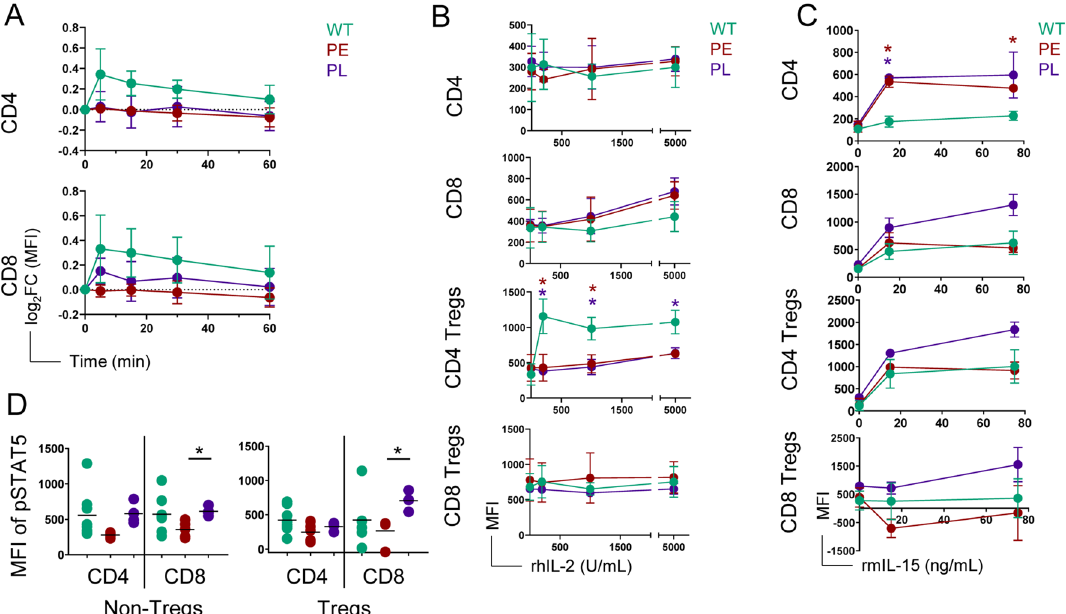
Figure 6. IL-2Rα-KO T cells respond differentially to cytokine stimulation. ( A ) Log 2 fold change of S6 phosphorylation by mean fluorescent intensity (MFI) from unstimulated over time following TCR stimulation comparing WT versus IL-2Rα-KO mice for CD4 and CD8 T cells. n = 2–4 mice per experimental group from 5 independent experiments. ( B ) MFI of phosphorylated STAT5 in 19-day-old WT and IL-2Rα-KO splenic T cells stimulated with rhIL-2 for 15 min with the indicated dosage. n = 2–3 mice per experimental group. ( C ) MFI of phosphorylated STAT5 in 19-day-old WT and IL-2Rα-KO splenic T cells stimulated with rmIL-15 for 15 min with the indicated dosage. n = 2–4 mice per experimental group from 2 independent experiments. ( D ) MFI of STAT5 phosphorylation in 19-day-old WT and IL-2Rα-KO T cells following 10 ng/mL rmIL-7 stimulation for 15 min. n = 4–8 mice per experimental group. Statistics: unpaired Student’s t test; *p < 0.05, **p < 0.01, ***p < 0.001. Non-significant comparisons are not shown. Statistics in ( B ) and ( C ) are compared to WT and colored by which IL-2Rα-KO group is being compared.